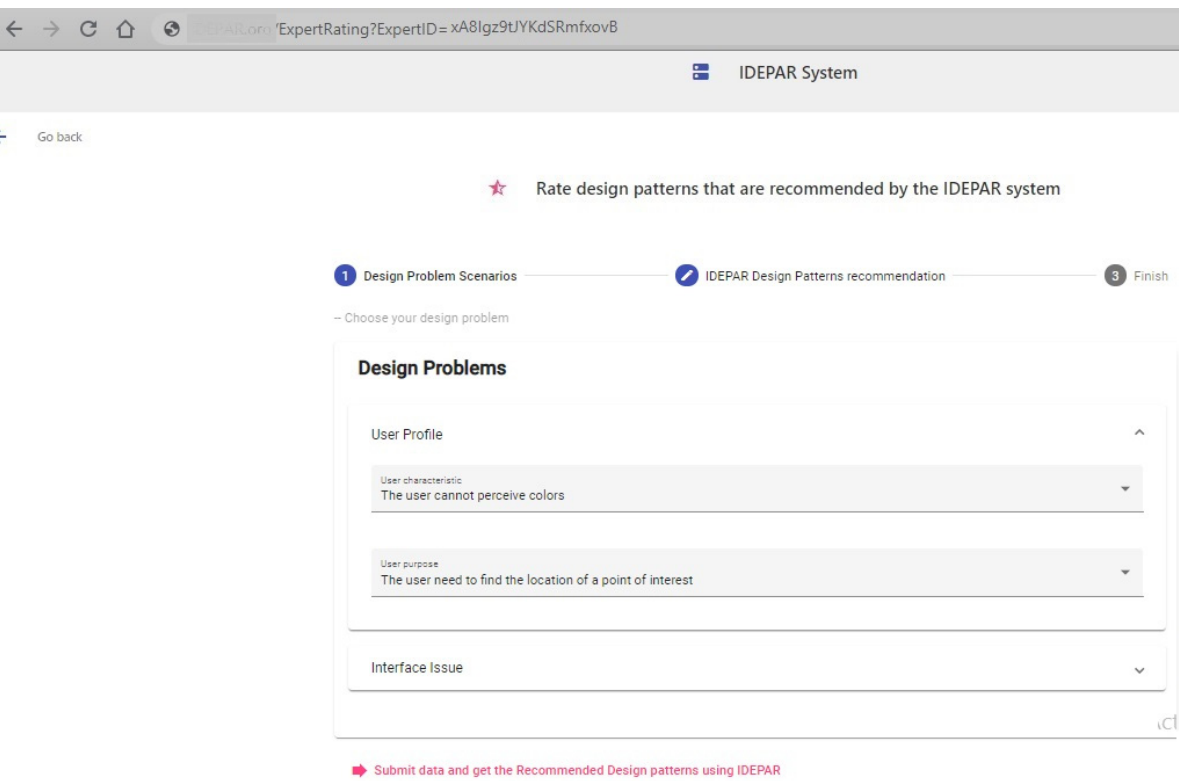
Figure 14. Selection of design problem DPS-1.